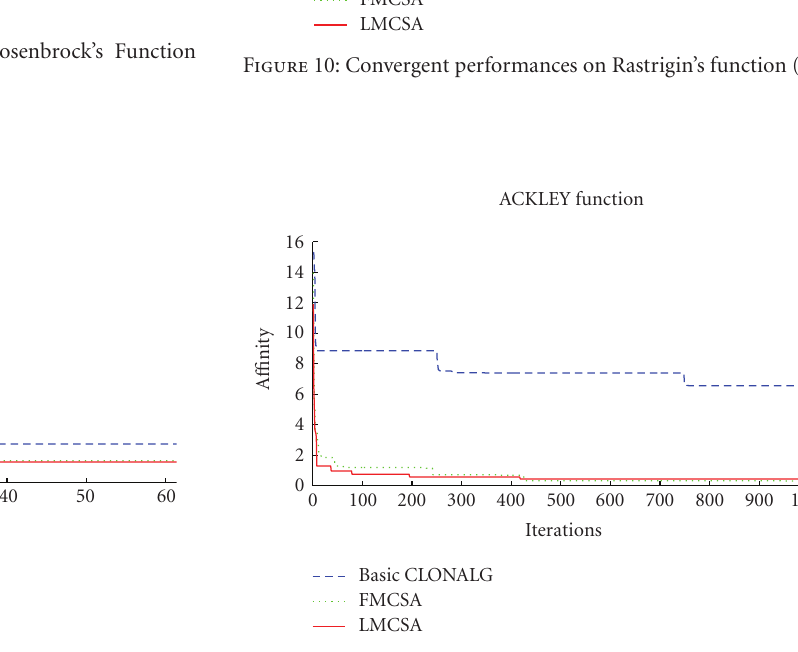
Figure 8: Convergent performances step function ( f 6).